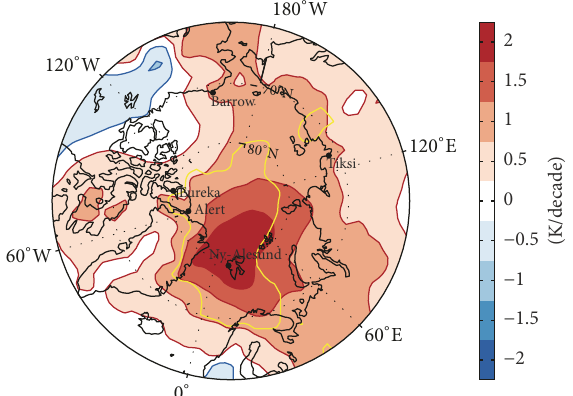
Figure 1: December-January-February (DJF) mean decadal tem- perature trend at the 850 hPa level using ERA-Interim 1996–2016. Regions of significant trends (95% confidence level) are bounded by a yellow